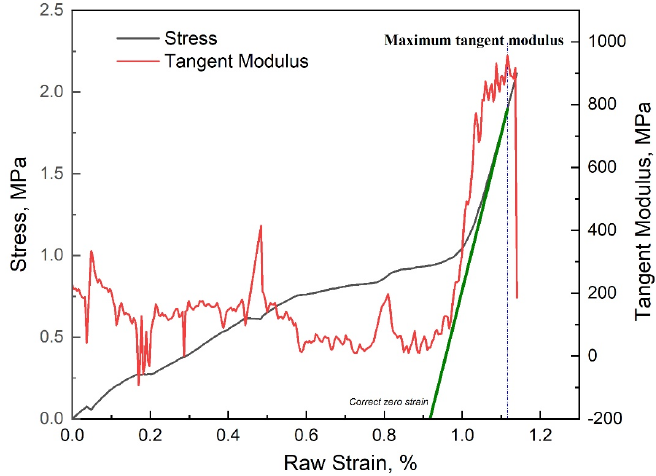
Figure 8. Correction of stress-strain curve in brittle regime. Table 1. Typical Experimental conditions and corrected results.